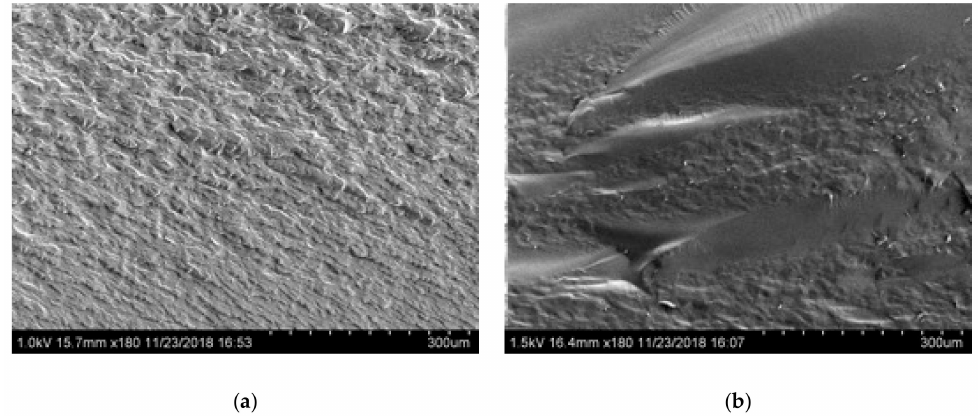
Figure 5. Morphology of gelatin samples after di ff erent setting time ( a ) 0.5 h and ( b ) 24